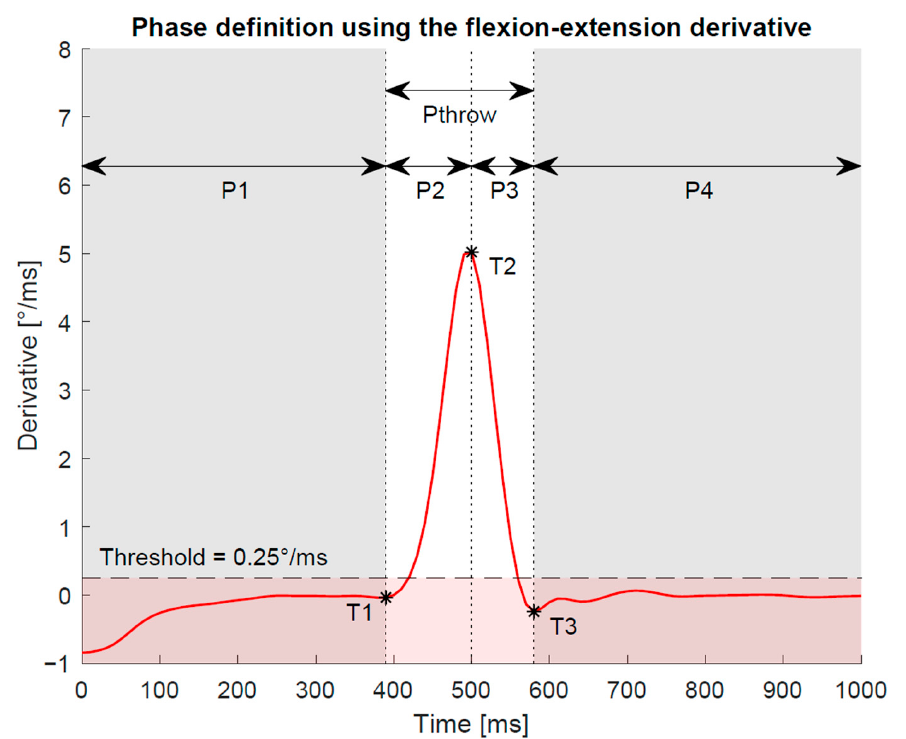
Figure 3. It was assumed that there is a relatively stable phase of the signal before (P1) and after (P4) the actual throw and that the throw movement is characterized by a high derivative. Hence, T1 was defined as the last time point before the peak derivative (T2), where the derivative lies below a certain threshold for more than 30 ms. Similarly, T3 was defined as the first time point after the peak derivative, where the derivative falls again below a certain threshold for more than 30 ms. Together, P2 and P3 represent the phase of the actual throw, P throw .